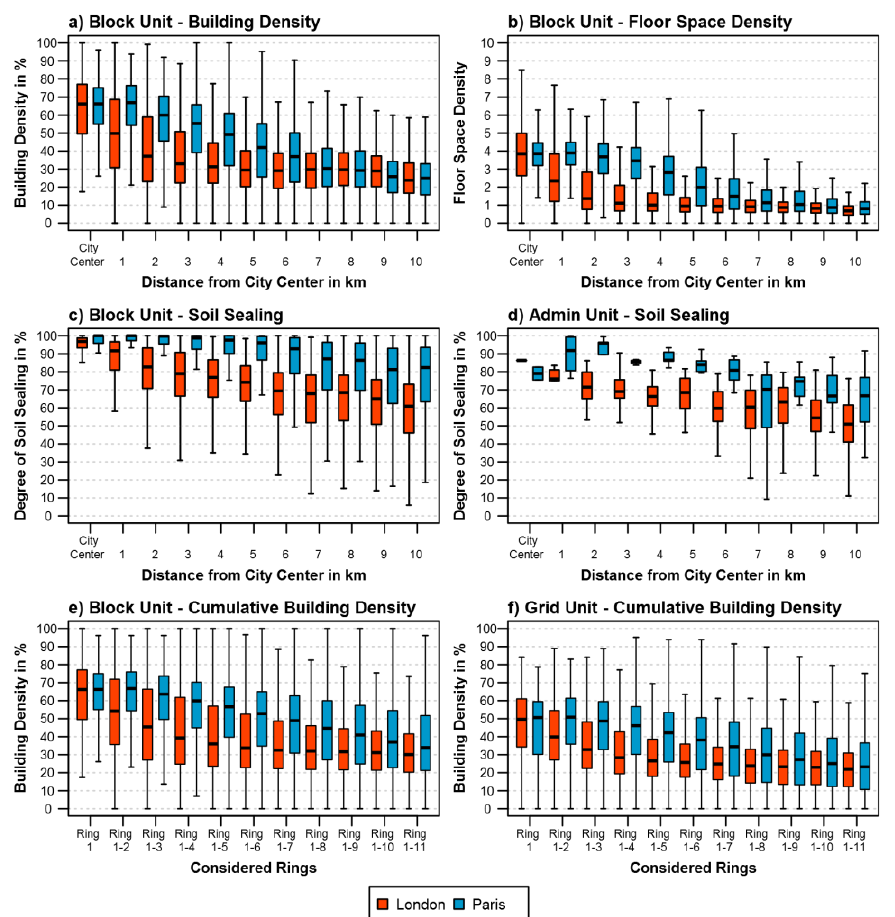
Figure 10. Gradient analysis for three thematic dimensions illustrated by site-specific boxplots on: ( a ) building density ; ( b ) floor space density ; and ( c ) soil sealing at block level for London and Paris. ( d ) For one example, soil sealing, the gradient analysis is presented at administrative units. For two other examples, using building density, the cumulative gradient analysis is illustrated for: ( e ) block units; and ( f ) grid units.